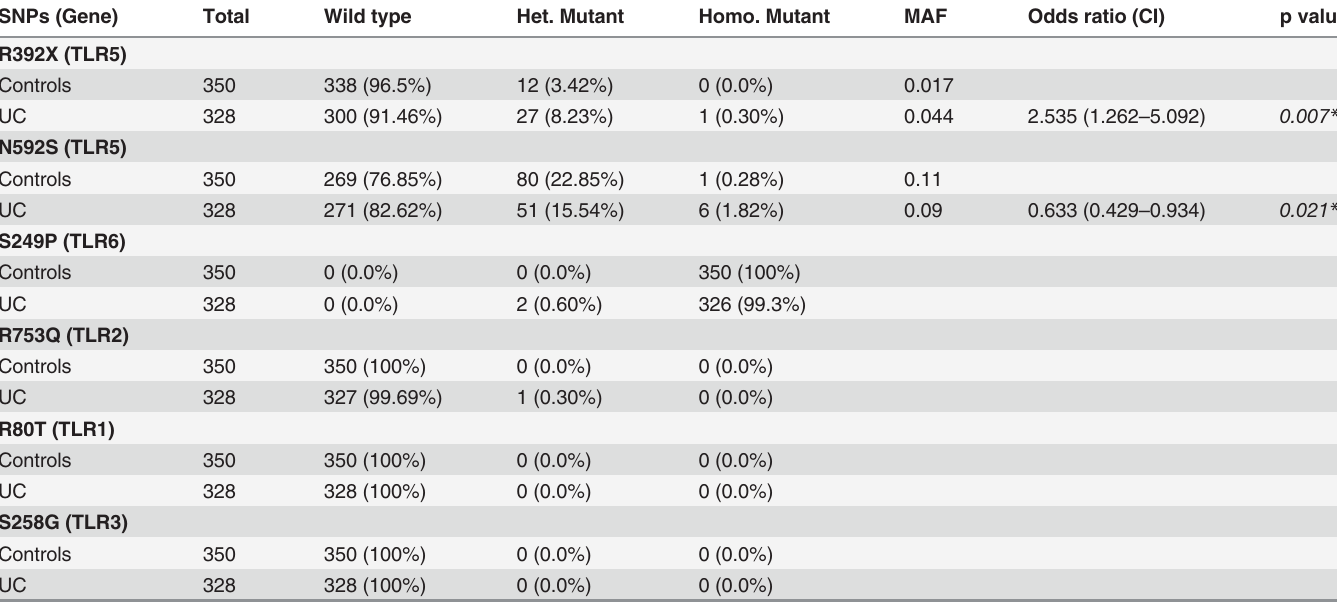
Table 3. Genotype and allele distribution for TLR variants in UC patients and controls.